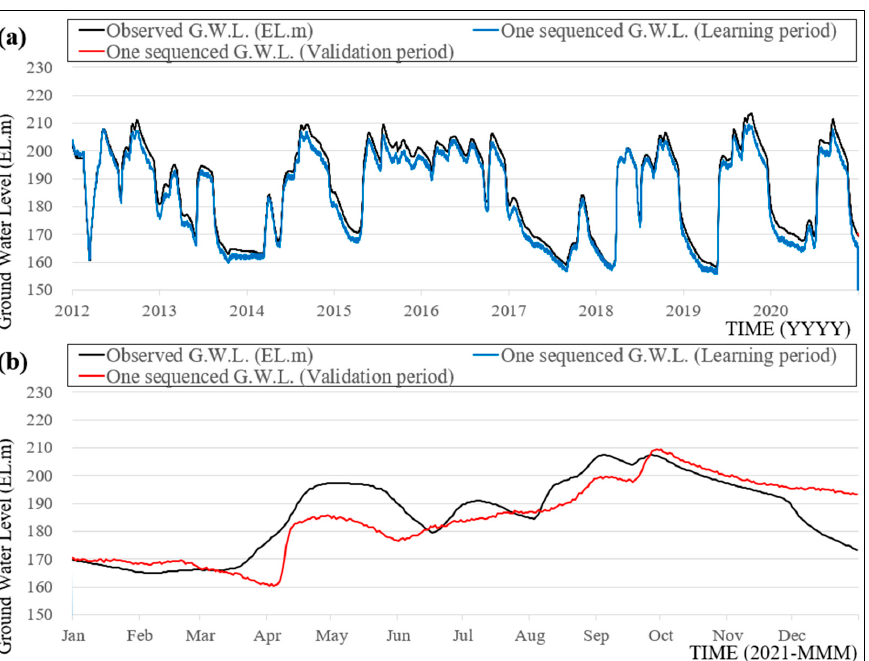
Figure 7. LSTM-simulated result of GWL with derivatives-based learning in daily scale: ( a ) learning period (2012 – 2020) and ( b ) validation period (2021).